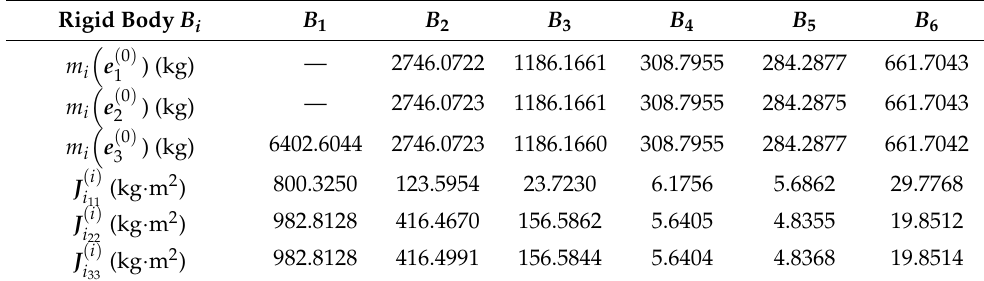
Table 2. Identified dynamic parameters of robot. Rigid Body